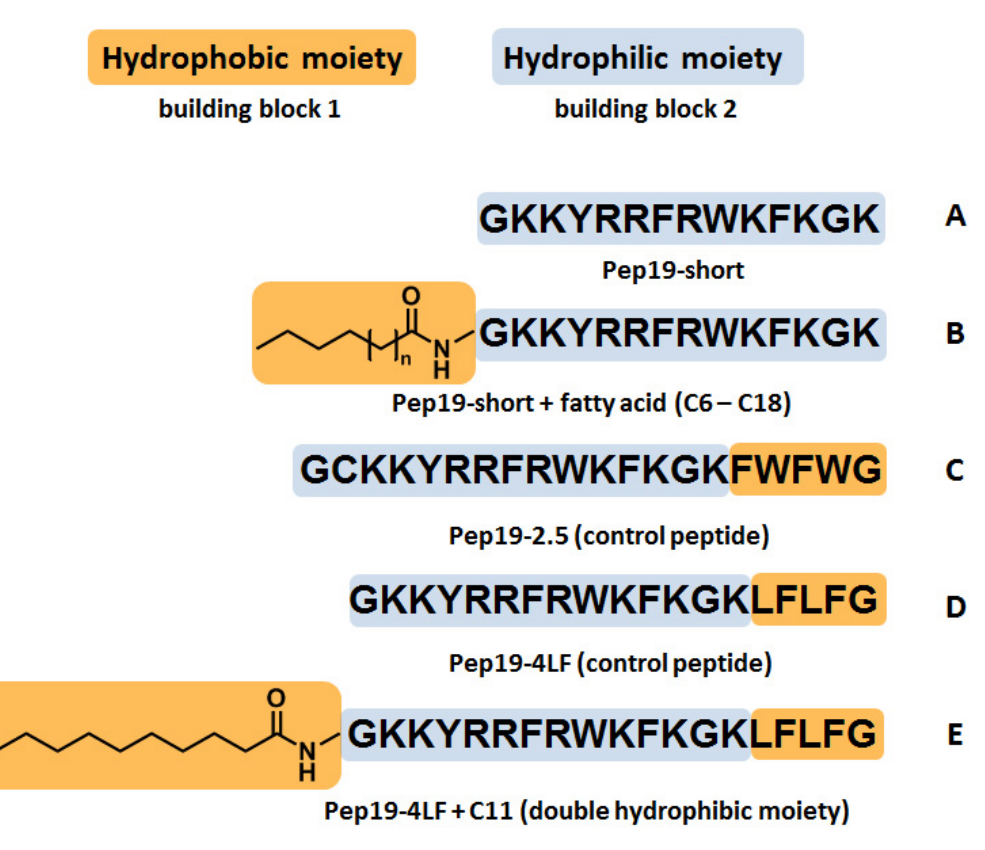
Figure 1. Schematic illustration of peptides synthesized and tested for antimicrobial activity by microdilution experiments: ( A ) Pep19-short, the peptide without a hydrophobic moiety, ( B ) Pep19-short conjugated to fatty acids including C6:0 (caproic acid), C8:0 (caprylic acid), C10:0 (capric acid), C11:0 (undecanoic acid), C12:0 (lauric acid), C14:0 (myristic acid), C16:0 (palmitic acid), and C18:0 (stearic acid), ( C ) Pep19-2.5 (original peptide), ( D ) Pep19-4LF (parent peptide), and ( E ) Pep19-4LF conjugated to undecanoic acid (C11:0) for an additional hydrophobic moiety.